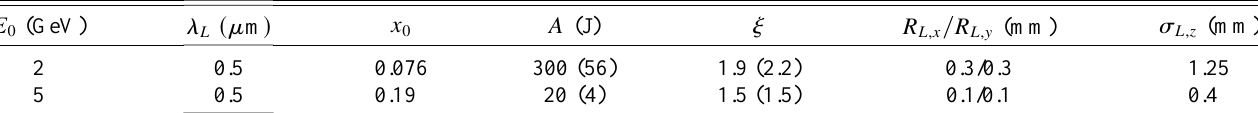
TABLE II. Parameters of the laser beams for laser-Compton cooling. The value in the parentheses is given by Telnov’s formulas.